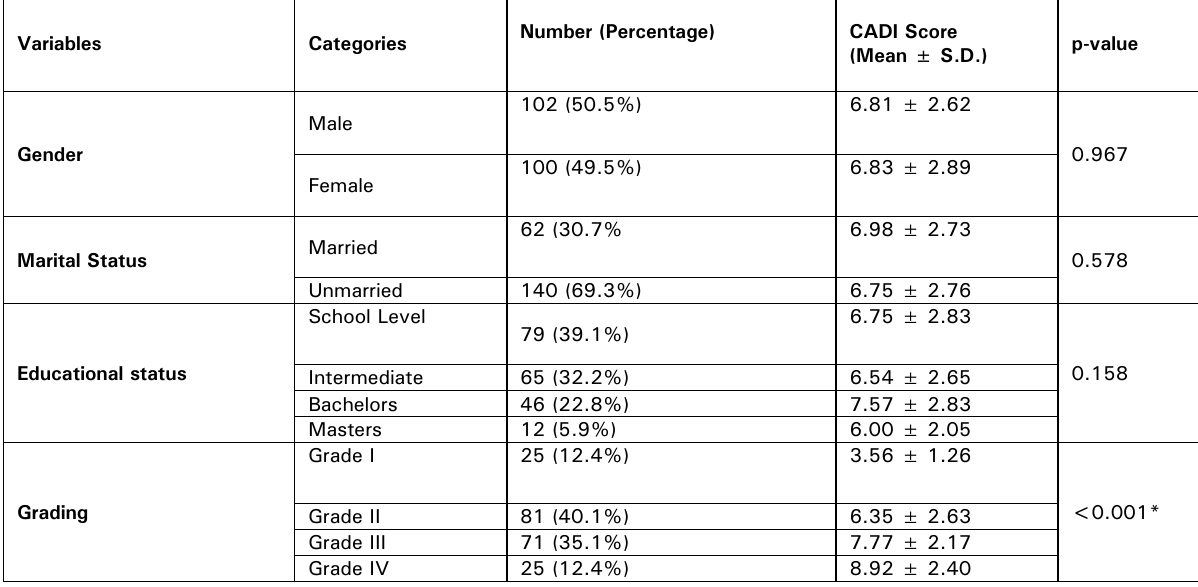
Table 1: CADI Score of Acne patients and its analysis for different